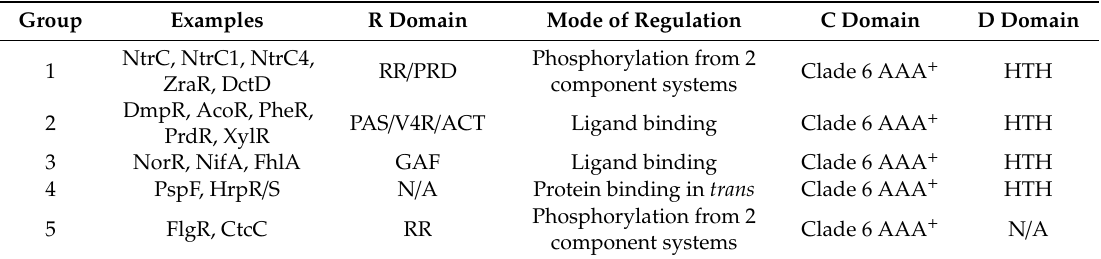
Table 1. An overview of the di ff erent groups of bEBPs. More information about clade 6 AAA + proteins is discussed below and in Figure